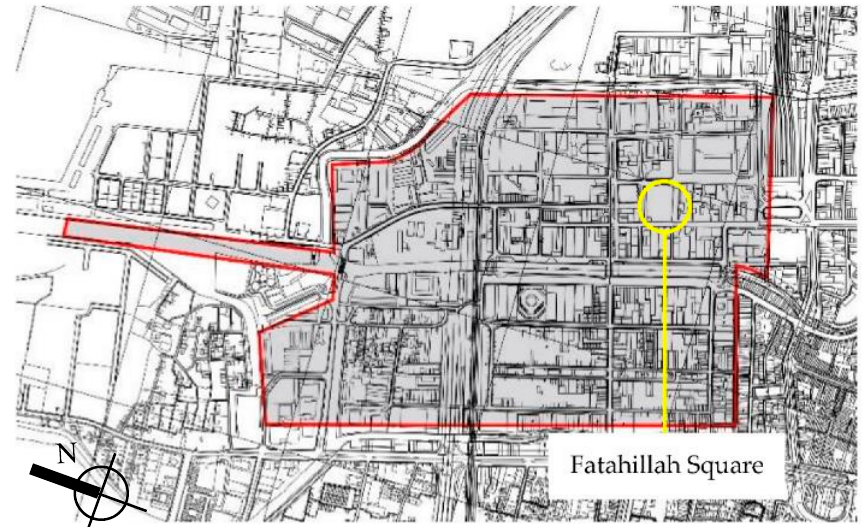
Figure 5. The map of Old Town of Jakarta in 2020. The red line is the wall of the city in the past.